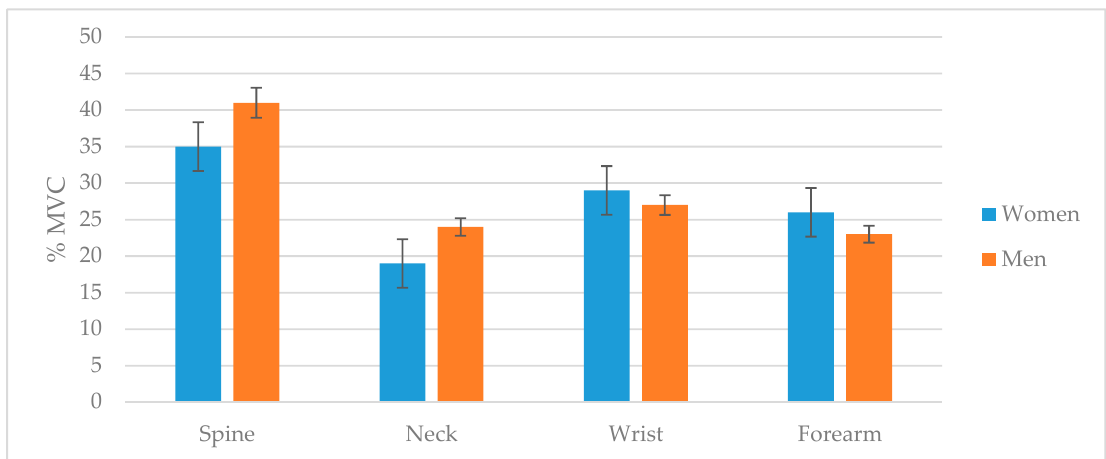
Figure 8. Mean muscle load in the during manual unloading of the maize silage.